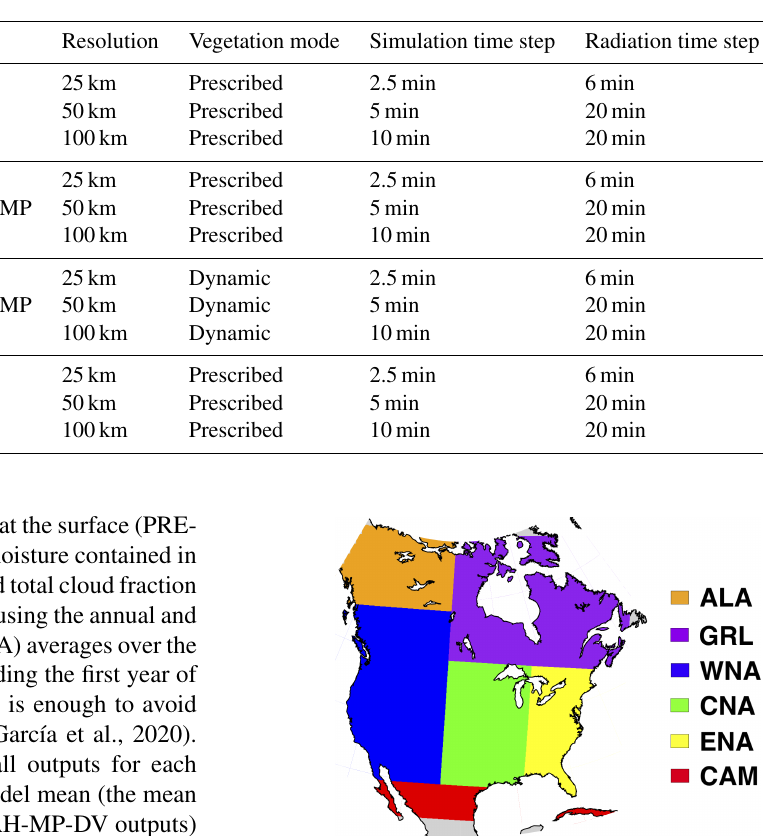
Table 1. Summary of the regional simulations performed in this analysis.